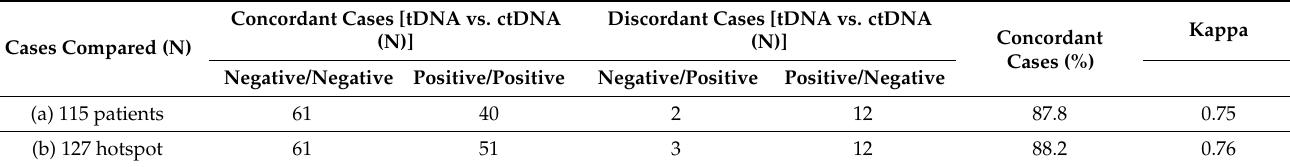
Table 3. Analysis of concordance between plasma and tissue genotyping on a patient basis (a), and hotspot alterations basis (b).